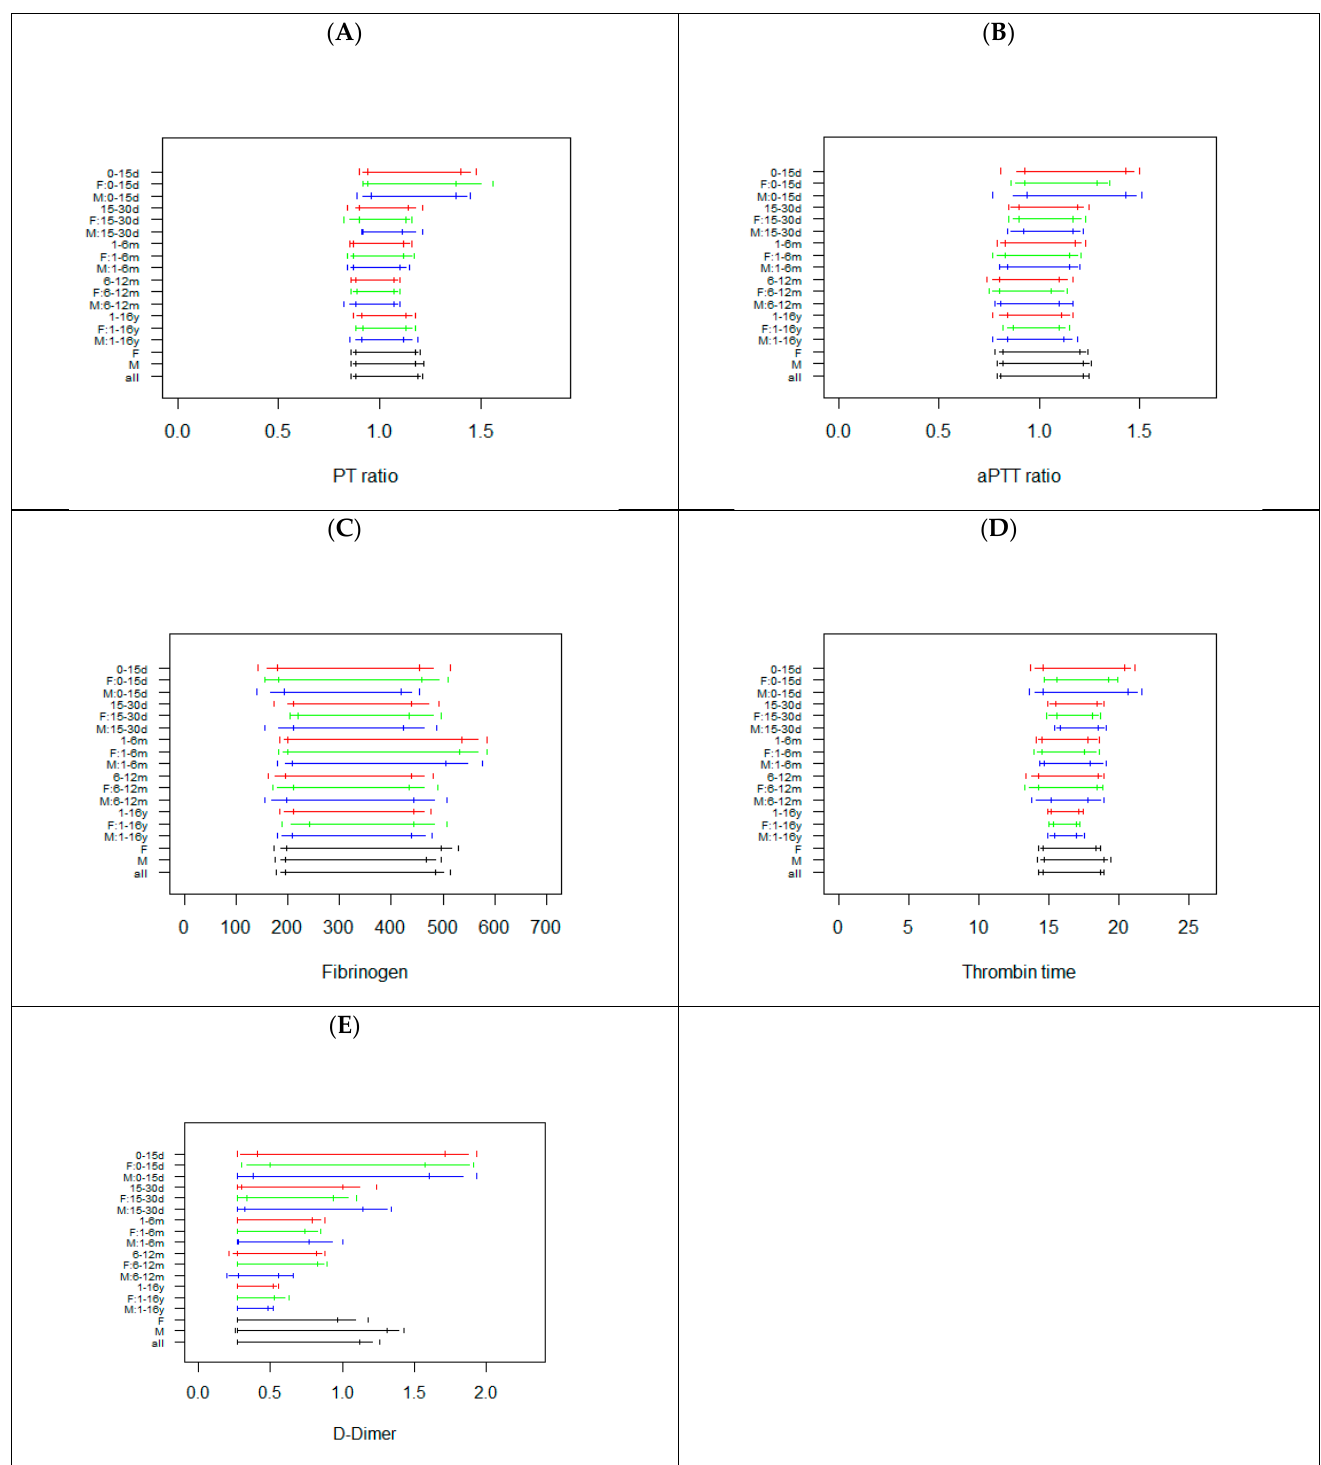
Figure 1. Reference intervals for PT ratio ( A ), aPTT ratio ( B ), Fibrinogen ( C ), TT ( D ), and D–Dimer ( E ) in the subjects subgrouped by sex and age. The horizontal segments represent the RIs, while the vertical segments indicate the limits of the 90% confidence interval of the RIs. For each class, RIs are reported combining males and females (red) or, respectively, only in females (green) or males (blue). The last three RIs are calculated without taking into account age, in females, males, or in the whole sample. d = days, m = months, y = years, F = females, M = males. With few exceptions (F: 0–15 d for aPTT, Fib, DD and TT; M: 6–12 m for TT, DD; M: and F: 1–16 y for TT) the sample size of the 90 subgroups (18 groups × 5 tests) investigated